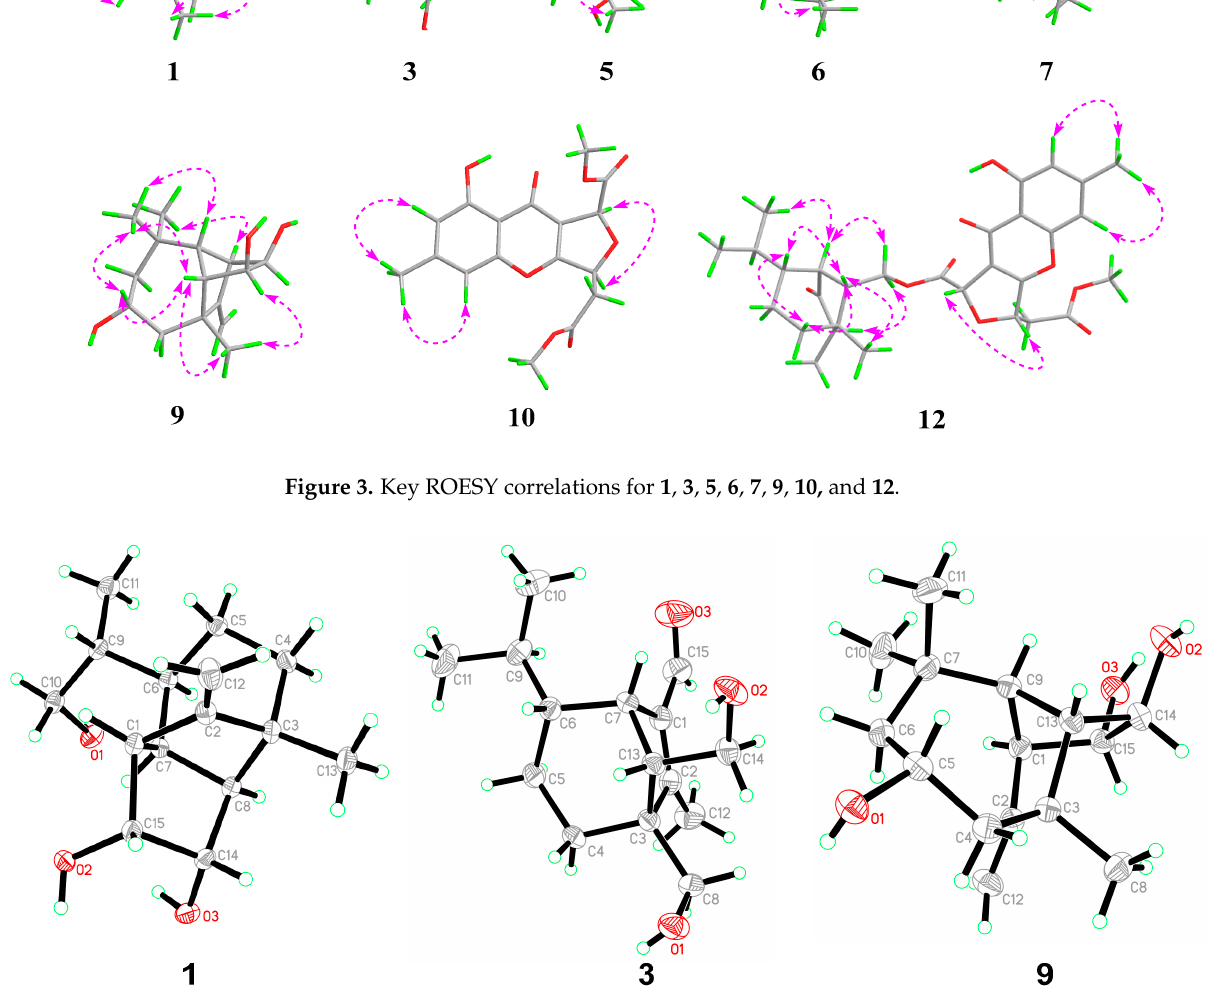
Figure 4 . ORTEP diagrams of 1 , 3, and 9 . Figure 4. ORTEP diagrams of 1 , 3, and 9